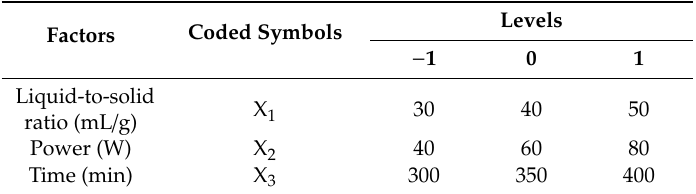
Table 4. Independent variables and their levels used for Box—Behnken design. Factors Coded